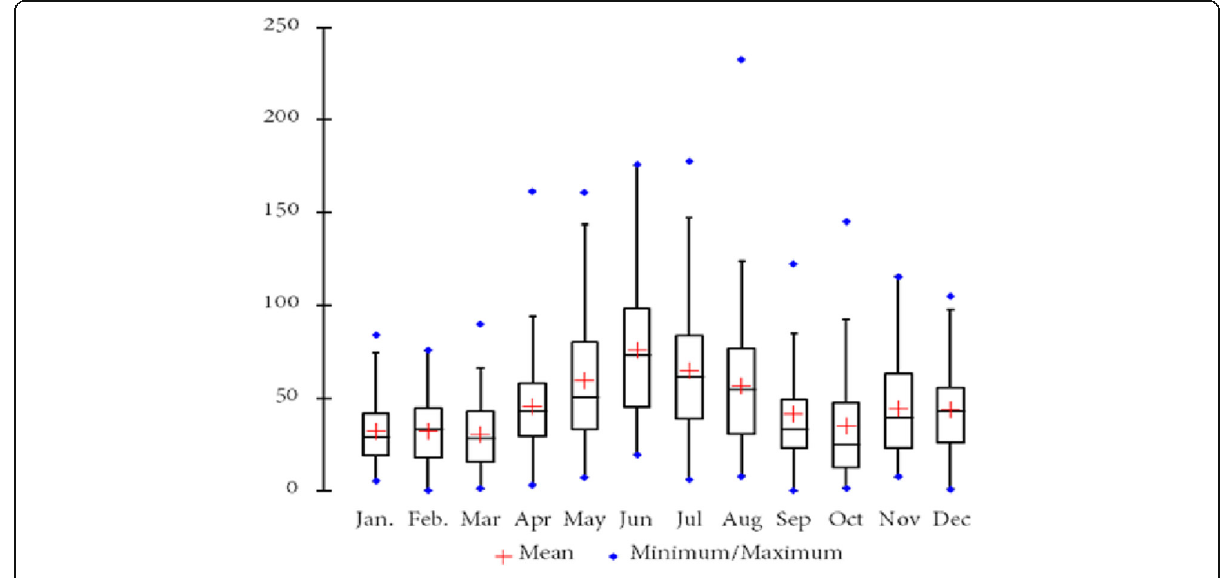
Fig. 3 Boxplot analysis of monthly rainfall from 1950 to 2010